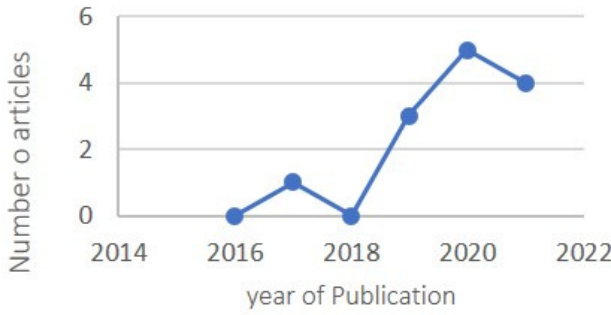
Figure 2. Publication year of included articles.